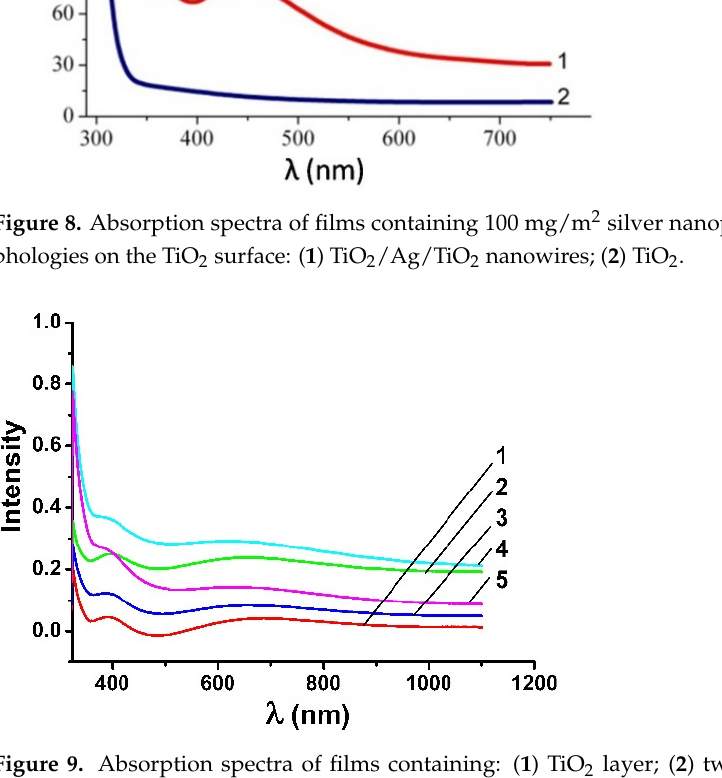
Figure 9. Absorption spectra of films containing: ( 1 ) TiO 2 layer; ( 2 ) two layers: TiO 2 /Ag_NW; ( 3 ) two layers: TiO 2 /Ag_NW_MW; ( 4 ) three layers: TiO 2 /Ag_NW/TiO 2 ; ( 5 ) three layers: TiO 2 /Ag_NW_MW/TiO 2 .